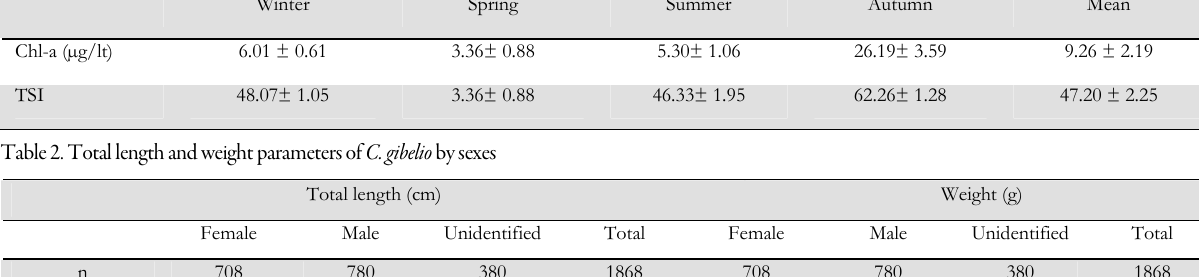
Table 1. Seasonal and mean chlorophyll- a (Chl- a ) and Trophic State Index (TSI) values of Beyşehir Lake